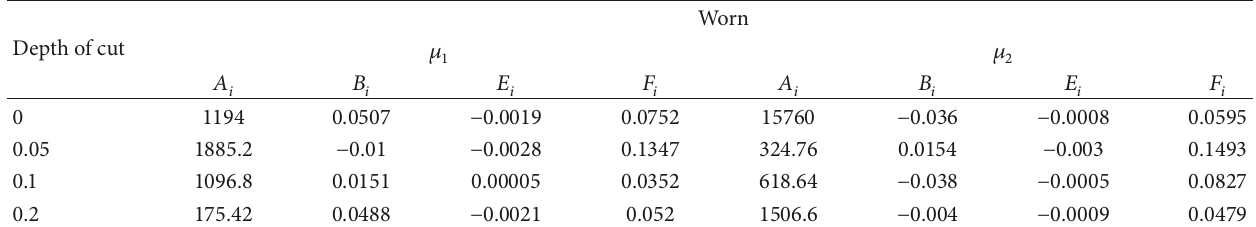
Table 7: Values of the parameter’s constants of the friction coefficient functions, in the case of the new insert. Depth of